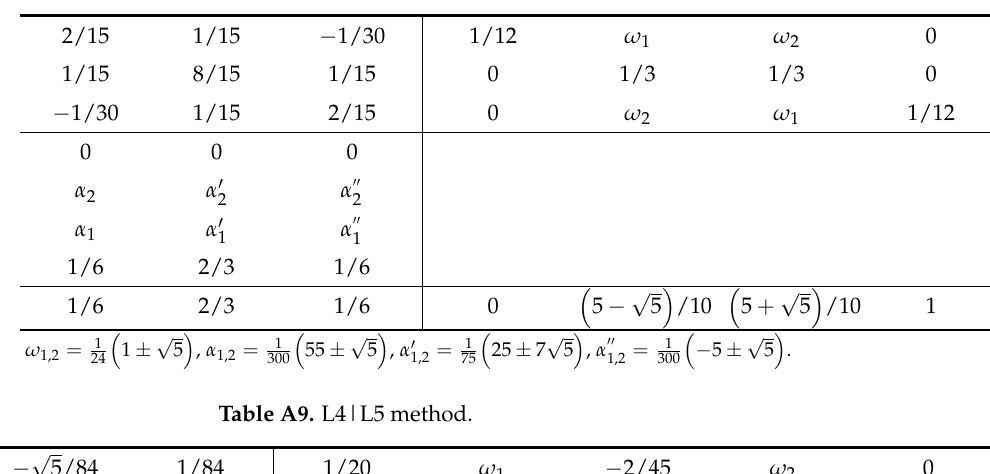
Table A8. L3|L4 method.